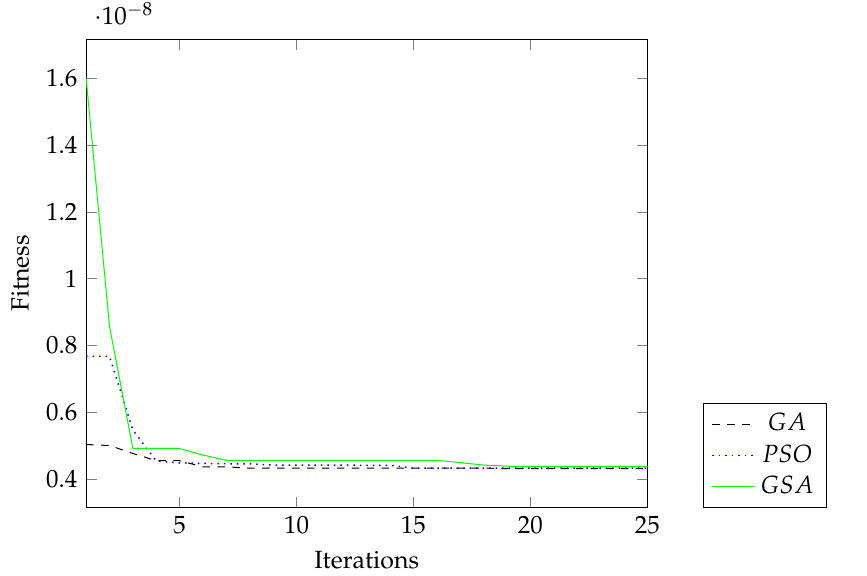
Figure 7. Convergence curves of the 33 MVA single-phase transformer using the GA, PSO and the GSA methods.